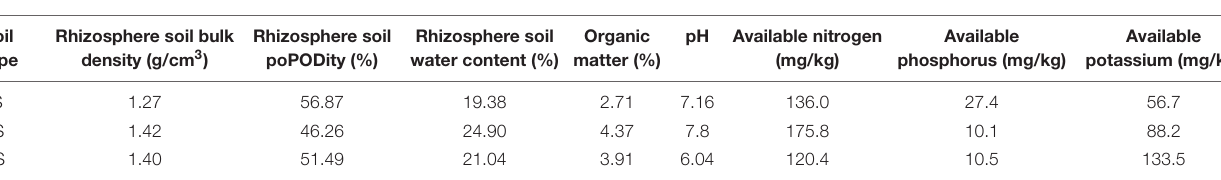
TABLE 1 | Nutrient contents of the soils used in the